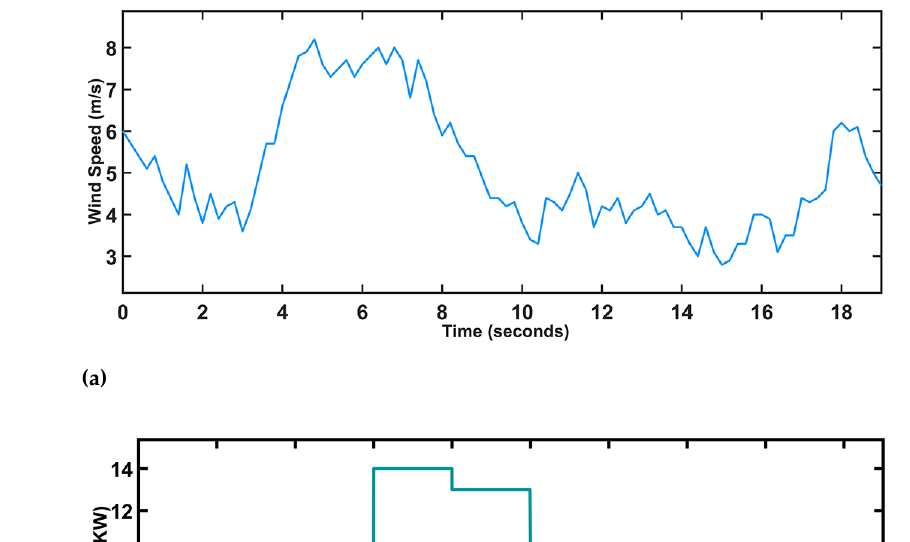
Figure 7. General structure of the controller.